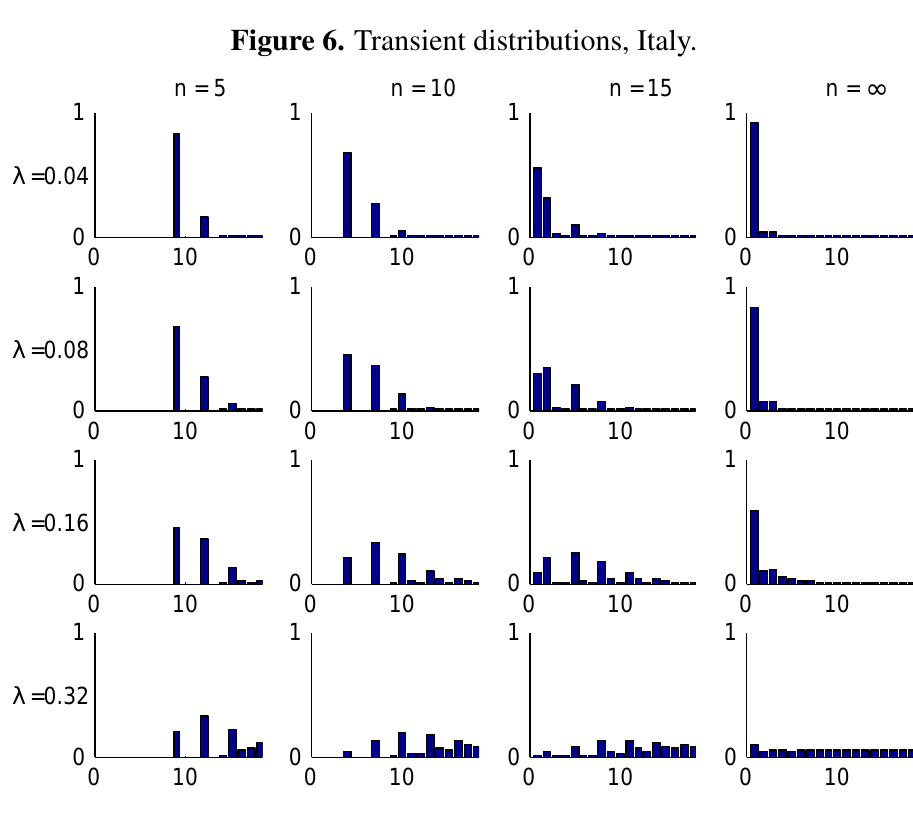
Figure 6. Transient distributions,